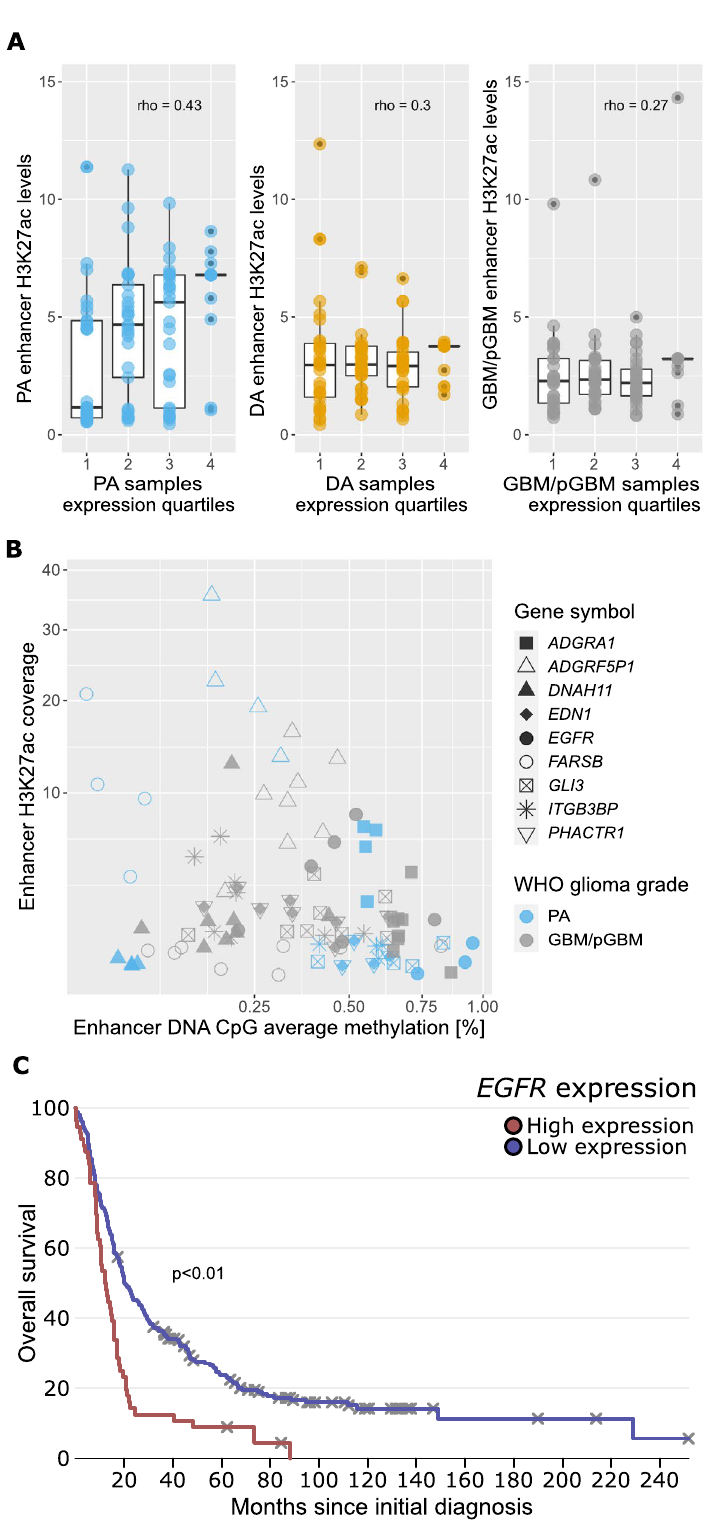
Figure 5. The effect of differential H3K27 acetylation and/or DNA methylation at enhancers on the expression of their target genes: PROTOCADHERINS , EGFR and other glioma-related genes. ( A ) Correlation between enhancers’ H3K27 acetylation and expression of DEGs (PA vs GBM/pGBM) contacting them. Correlation decreases in higher grade gliomas. ( B ) Correlation between DNA methylation and H3K27ac signals at the enhancers being in contact with DEGs and being differentially methylated and acetylated (H3K27ac) between PA vs GBM/pGBM samples. Each dot represents a gene in each sample—9 genes in 12 samples for which there were simultaneously available good quality DNA methylation and H3K27ac data. ( C ) Survival analysis plot of the expression of EGFR gene showing its prognostic value for glioma patients’ survival, based on the Rembrandt